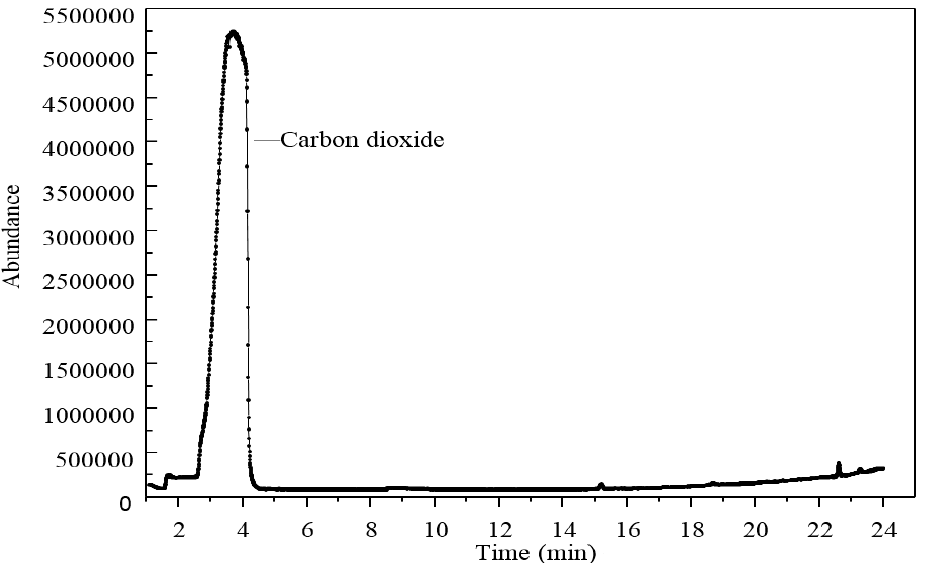
Figure 19. Gas chromatography of 3% GO-modified asphalt heated to 115 °C.